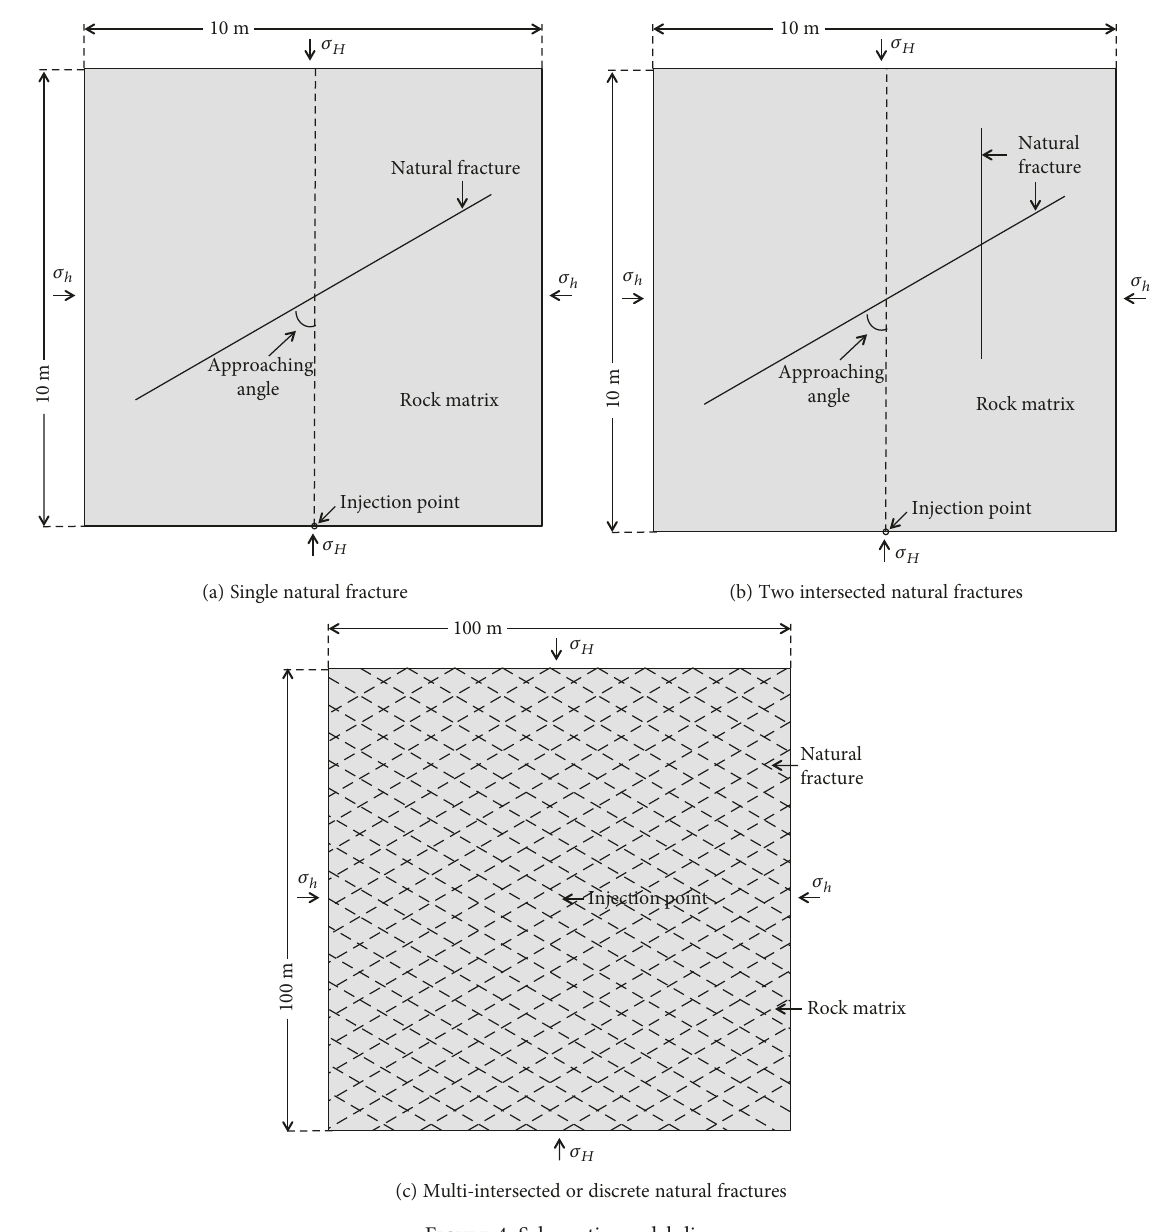
Figure 4: Schematic model Table 1: Basic model parameters.